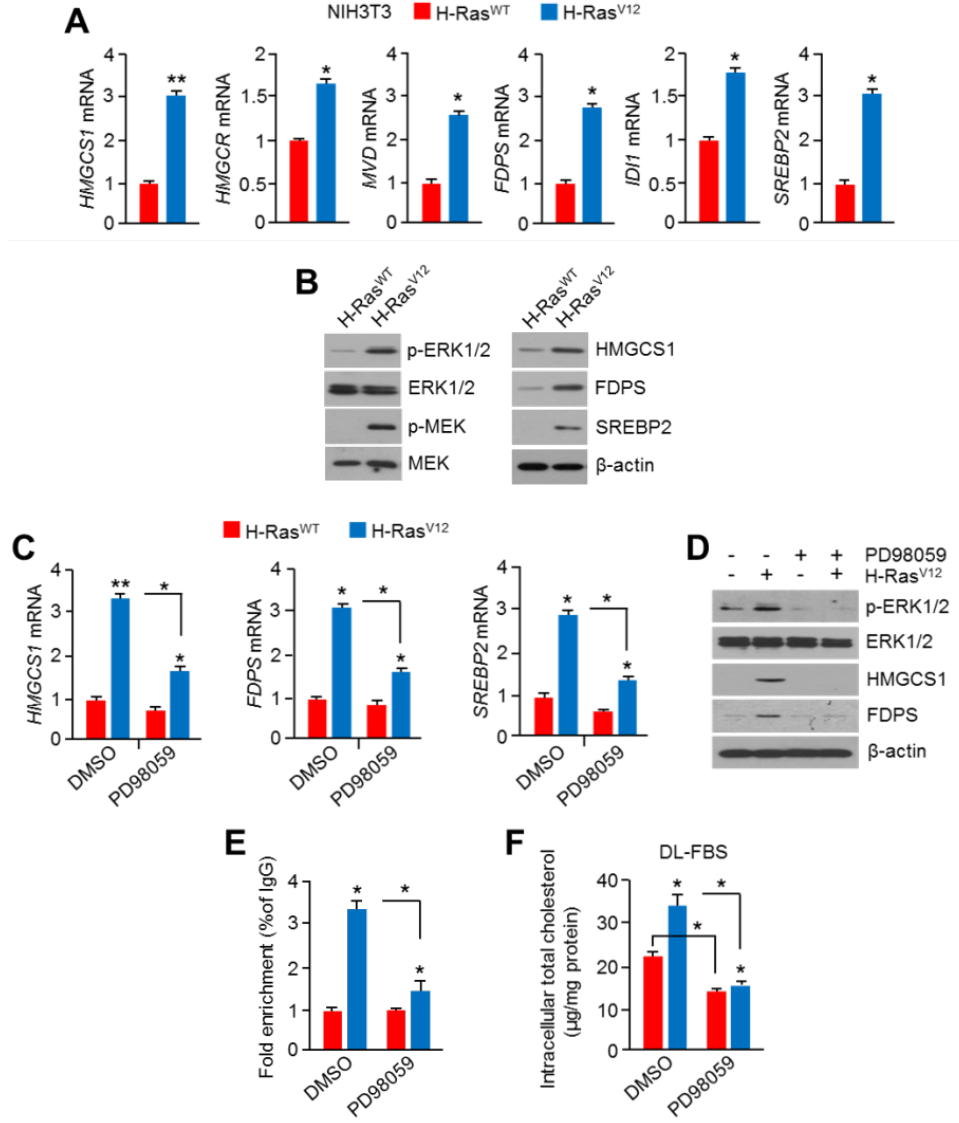
Figure 4. Constitutive activation of RAS-MAPK signaling promoted the mevalonate and cholesterol biosynthesis pathway. ( A ) Mevalonate and cholesterol biosynthesis-related mRNA levels were measured in H-Ras V12 -overexpressing NIH3T3 cells. The values represent the mean ± SD of two independent experiments performed in triplicate. ( B ) Activation of MAPK signaling and cholesterol biosynthesis-related protein expression was measured in H-Ras V12 -overexpressing NIH3T3 cells. ( C , D ) The MAPK inhibitor PD98059 (20 µ M) was treated in H-Ras V12 -overexpressing NIH3T3 cells for 12 h, and then mRNA and protein levels were measured. The values represent the mean ± SD of two independent experiments performed in triplicate. ( E ) H-Ras WT - or H-Ras V12 -overexpressing NIH3T3 cells were cultured for 24 h in the absence or presence of PD98059 (10 µ M), and then cells were used for ChIP-PCR. Cell lysates were immunoprecipitated with anti-HSF1 for 16 h at 4 ◦ C. Immunoprecipitated complexes were washed and pulled-down DNA fragments obtained. HSF1 enrichment on the hmgcs1 promoter was measured by qPCR, and fold enrichment was normalized to normal serum (IgG) control. The values represent the mean ± SD of three independent experiments performed in duplicate. ( F ) H-Ras WT - or H-Ras V12 -overexpressing NIH3T3 cells were cultured for 24 h in a DL-FBS condition in the absence or presence of PD98059 (10 µ M), and then cells were used to measure intracellular cholesterol levels. The values represent the mean ± SD of three independent experiments performed in duplicate. * p < 0.05 and ** p < 0.01.